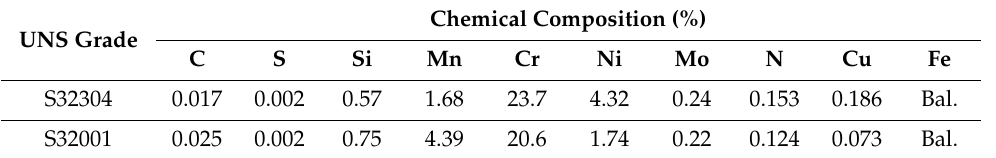
Table 2. Chemical composition (w / w) of the duplex stainless-steel bars. UNS